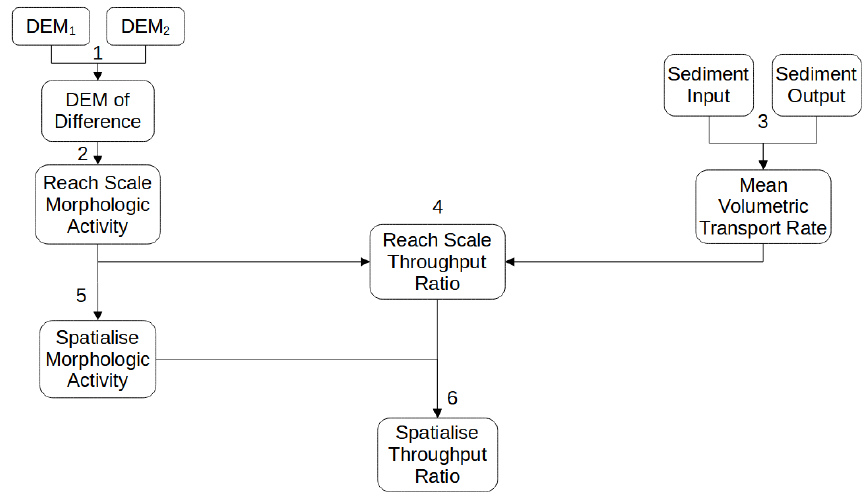
Figure 2. Flowchart representing the methodology used to create ζ . Numbers represent processing stages: (1) surface differencing (Eq. 5a), (2) calculating absolute change at the reach scale (Eq. 5b), (3) volumetric conversion and averaging (Eq. 4), (4) calculating reach-scale ζ (Eq. 3), (5) spatialising M (see Fig. 8), and (6) spatialising ζ (Eq.